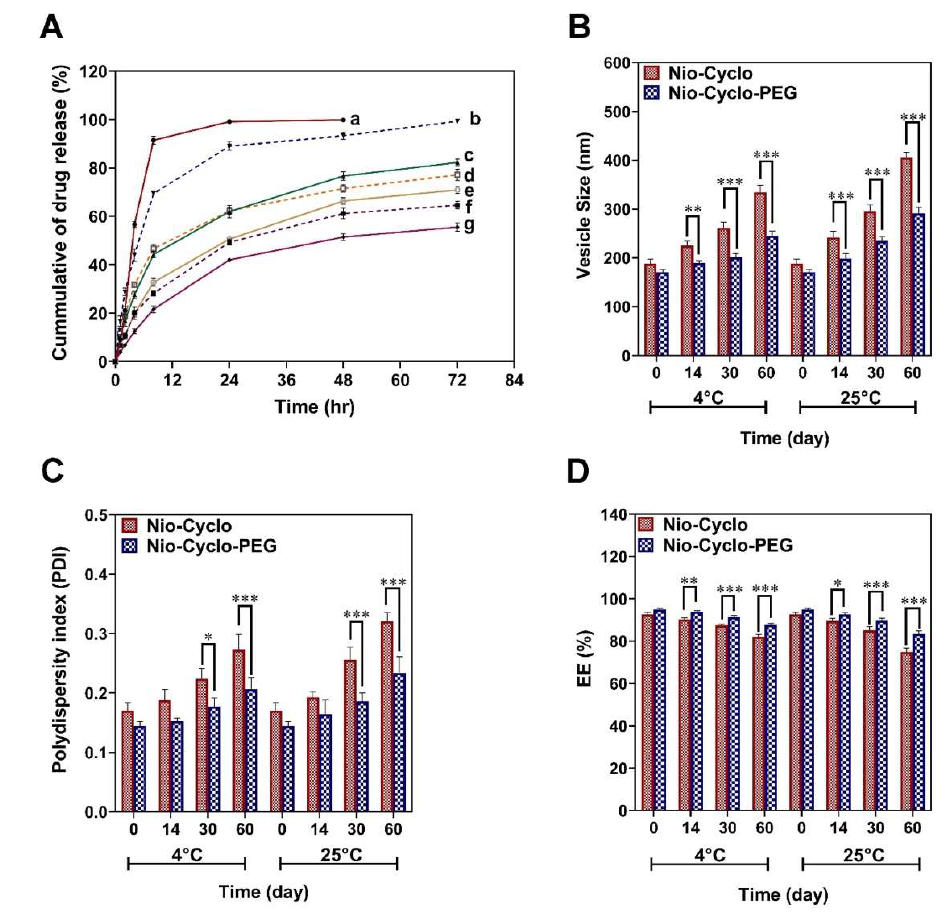
Figure 3. ( A ) In vitro drug release profile of cyclophosphamide from the Nio-Cyclo and Nio-Cyclo- PEG nanocarriers at 37 ◦ C. ( a ) Free Cyclophosphamide (Cyclo), ( b ) Nio-Cyclo at pH 1.2, ( c ) Nio-Cyclo at pH 5.4, ( d ) Nio-Cyclo-PEG at pH 1.2, ( e ) Nio-Cyclo-PEG at pH 5.4, ( f ) Nio-Cyclo at pH 7.4, and ( e ) Nio-Cyclo-PEG at pH 7.4; ( B – D ) Stability of optimum Nio-Cyclo and Nio-Cyclo-PEG formulations after 2 months of storage at 4 and 25 °C. Data are represented as Mean ± SD from three independent experiments (*: p < 0.05, **: p < 0.01 and ***: p < 0.001). The release kinetics of cyclophosphamide drug from the Nio-Cyclo and Nio-Cyclo- PEG nanocarriers are presented in Table 6. The free cyclophosphamide (Cyclo) follows the first-order kinetic model. According to this first-order model, the drug release rate from the Nio-Cyclo and Nio-Cyclo-PEG nanocarriers were determined from the correla-